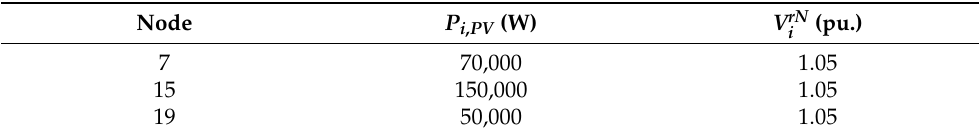
Table 6. The details of PV nodes.